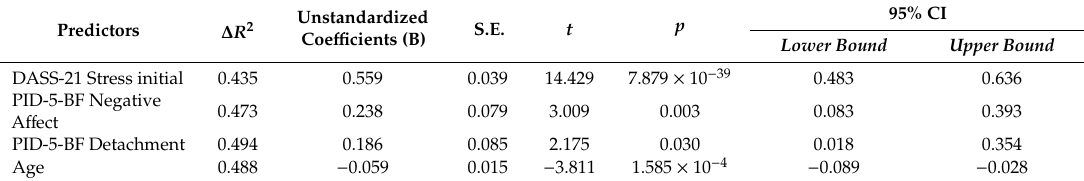
Table 4. Multiple Linear Regression Model Predicting the DASS-21 Stress Subscale Score During the Final Period of the Lockdown.